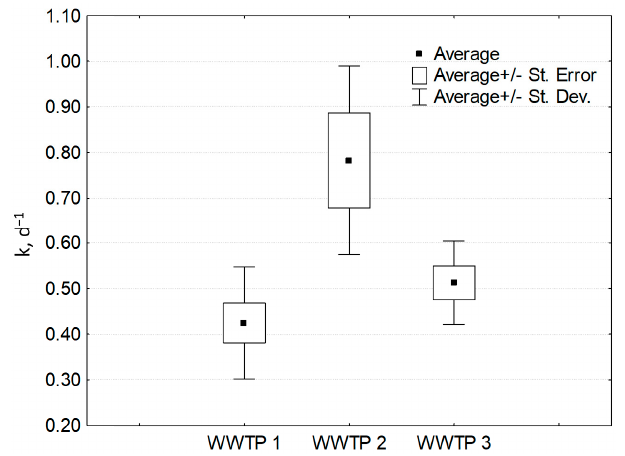
Figure 10. Differentiation of biodegradation rates k in analysed samples.